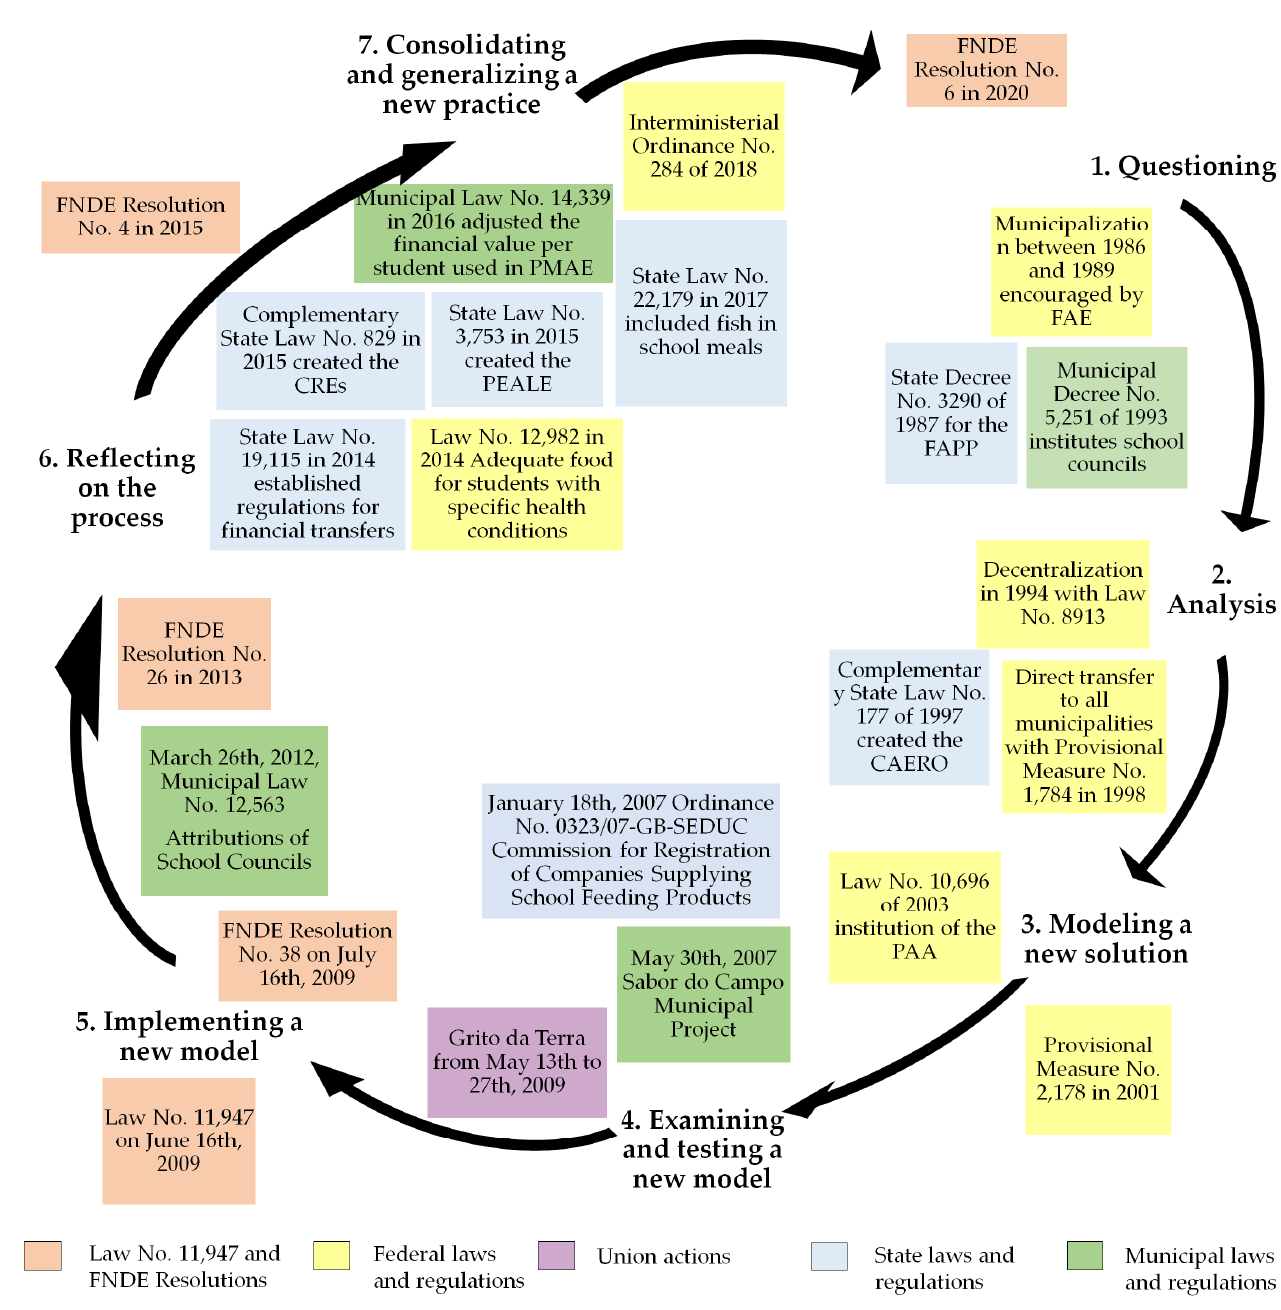
Figure 1. Expansive learning cycle of the PNAE in the municipality of Porto Velho. (Source: based on Engeström and Sannino (2010) using own data).